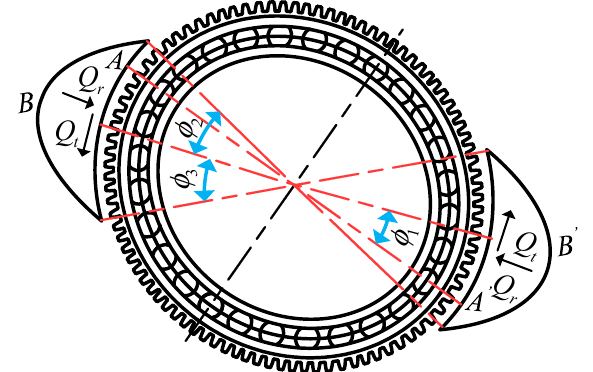
Figure 15. Load distribution diagram of the flexible wheel.